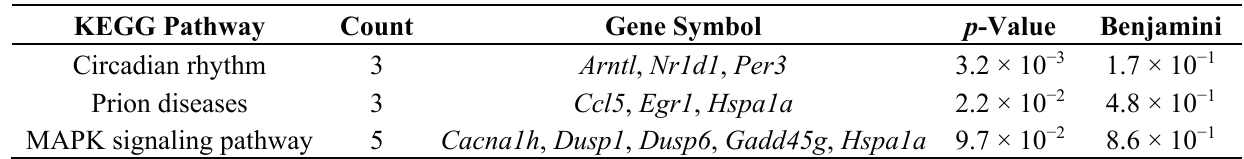
Table 3. Significantly regulated KEGG pathways in the kidney shared by L -NAME and L -NAME + CIT-treated offspring vs. control at three months of age.